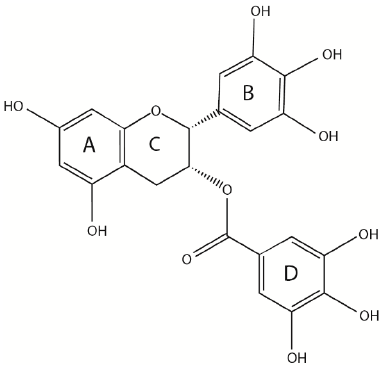
Figure 1. Structure of epigallocatechin-3-gallate (EGCG).